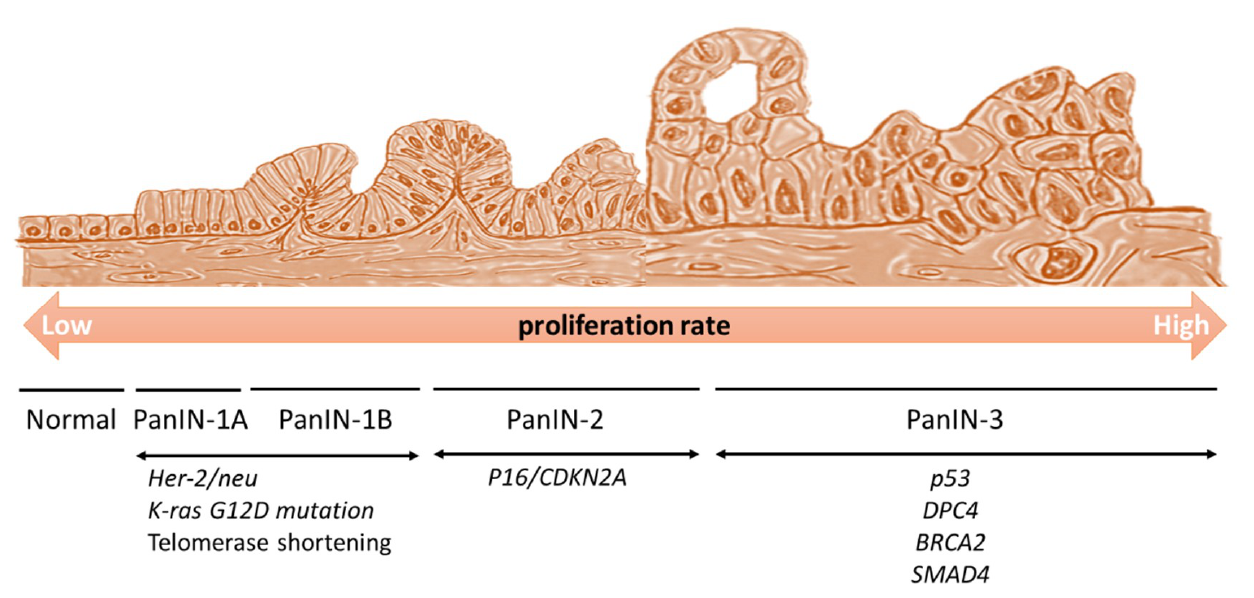
Figure 2. Generation of pancreatic intraepithelial neoplasia (PanIN). The Kras oncogene is activated and increases cell proliferation. Her-2/neu expression and telomere shortening also occur at the initial stages of the disease. If tumor suppressor genes are inactivated, there is no stopper, and the cell cycle proceeds extensively. p16 Ink4a is activated at the PanIN-2 stage, and then p53, DPC4, and BRACA2 are activated at the PanIN-3 stage, to induce a high cellular proliferation. Subsequently, the cells enter the neoplastic stage.